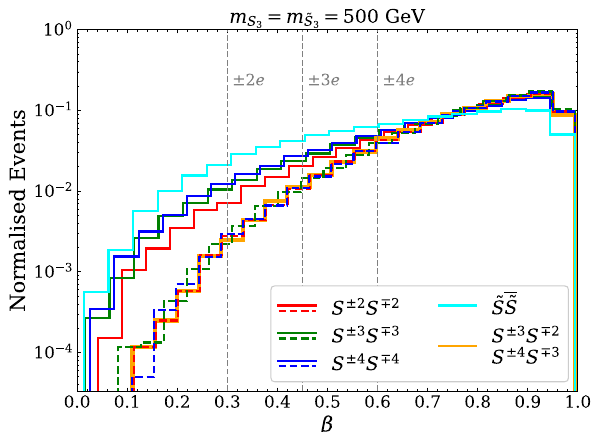
Fig. 4 Velocity distributions of the produced multi-charged particles in various production modes in Model-1 and -2. The masses are set to be 500 GeV for all particles. The dashed curves correspond to the velocity distributions without the contribution from the photon fusion process. The orange curve include the contributions from two associ- ated production modes, pp → S + 3 S − 2 and S + 4 S − 3 , mediated by a s -channel W -boson. The cyan curve shows the velocity distribution by the QCD production in Model-2, i.e. pp → ˜ S + 4 / 3 ˜ S − 4 / 3 , ˜ S + 7 / 3 ˜ S − 7 / 3 and ˜ S + 10 / 3 ˜ S − 10 /